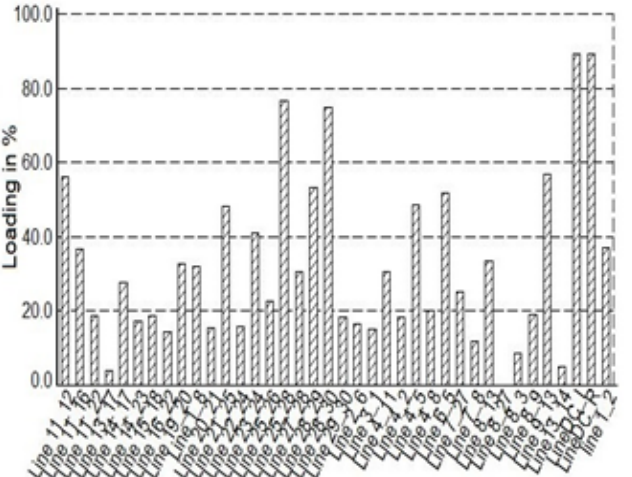
Fig. 15. Line loading (with HVDC line).